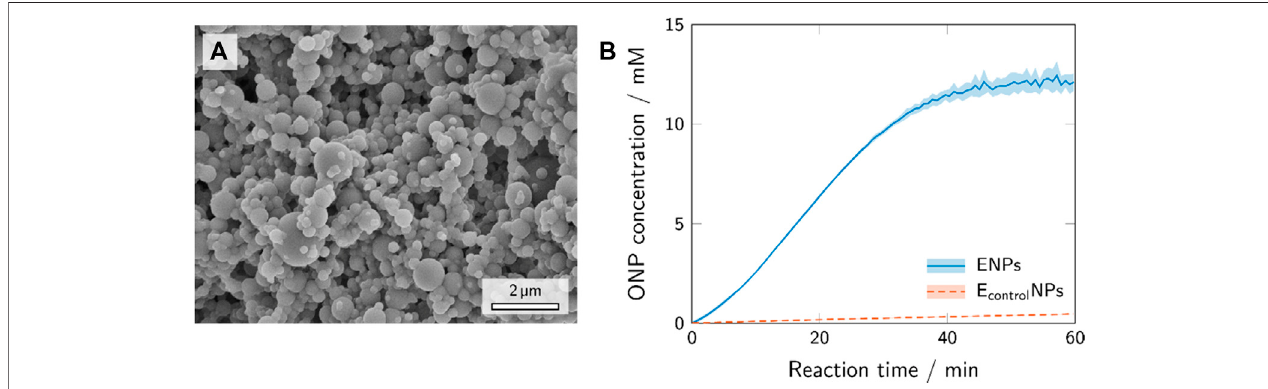
FIGURE 4 | SEM image of the polymer nanoparticles after the synthesis via aerosol photopolymerization (A) and the activity assays of the enzyme-conjugated polymer nanoparticles and polymer nanoparticles with unspeci fi cally adhered enzyme, i.e., control experiment (B)